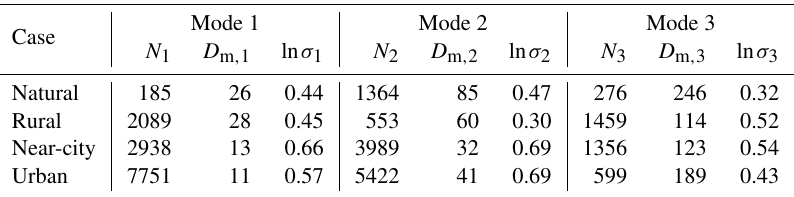
Table 2. Number concentration (cm − 3 ), median diameter (nm), and geometric standard deviation for the four cases studied in Van Dingenen et al. (2004) during summertime